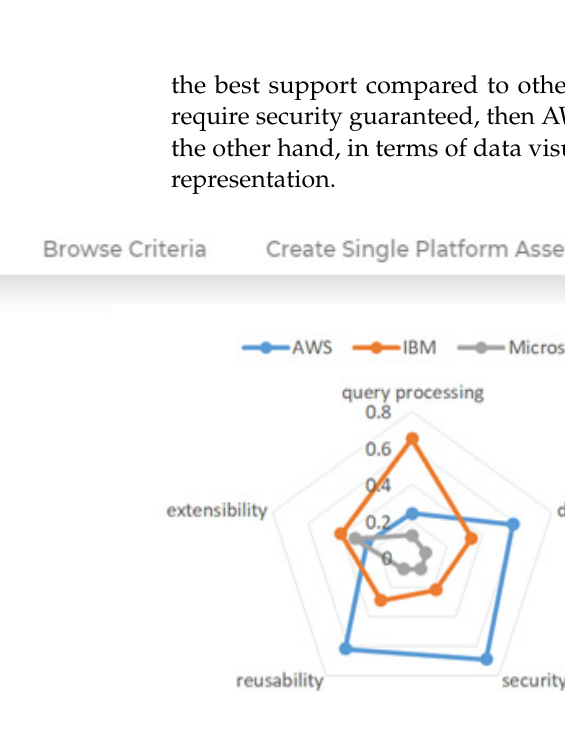
Figure 8. Comparison of IoT platforms for the criteria query processing (c 1 ) and data visualization (c 2 ) and three non- functional criteria security (c 3 ) , reusability (c 4 ) , and extensibility (c 5 )